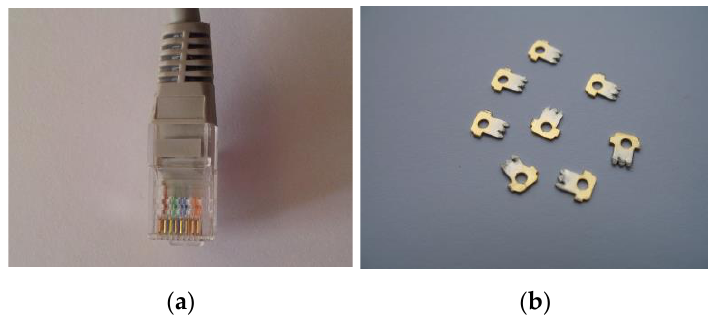
Figure 8. ( a ) Modular connector RJ 45 (8P8C); ( b ) recycled pins.